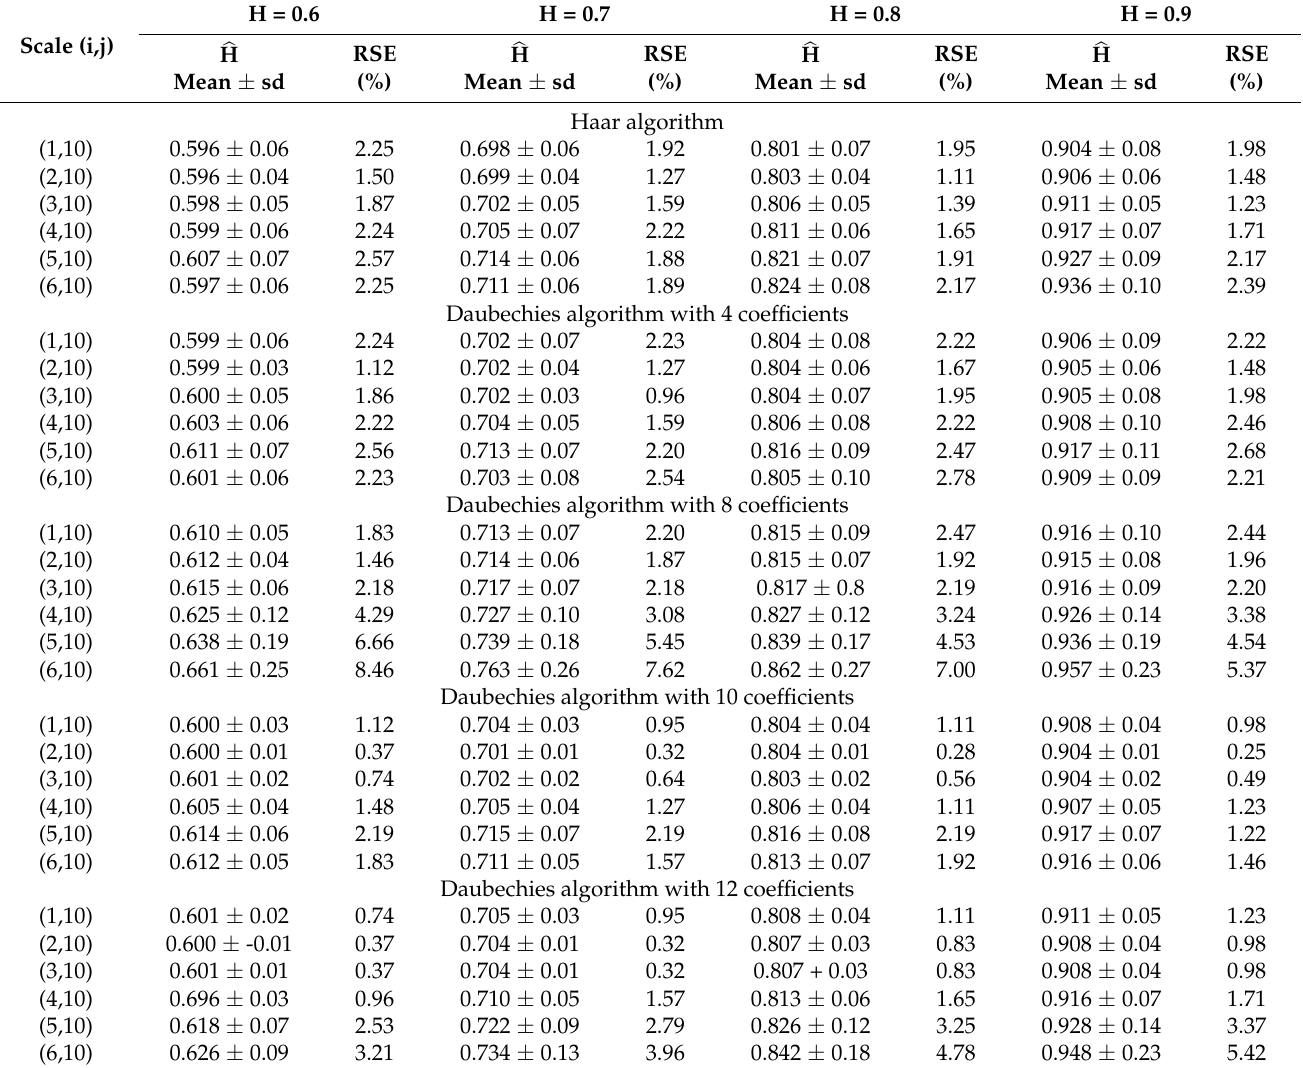
Table 2. Determining the value and relative error of the Hurst exponent using a wavelet-based